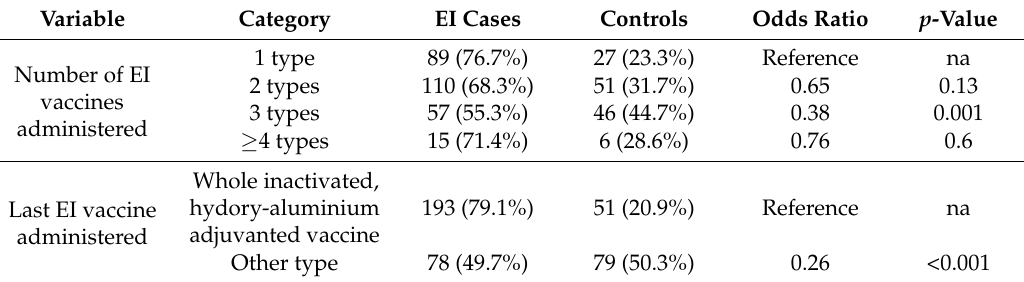
Table 1. Impact of mixed EI vaccination during the 2003 EI outbreak in Newmarket (UK), from [26]. Significance was set at p -value ≤ 0.05 (bold